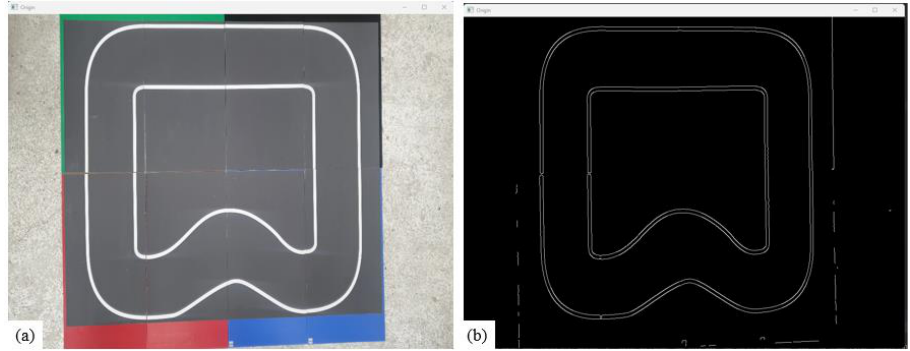
Figure 7. Marking the lane markers of the test track, ( a ) the image of the test track background, and ( b ) the image of the lane marker of the test track.